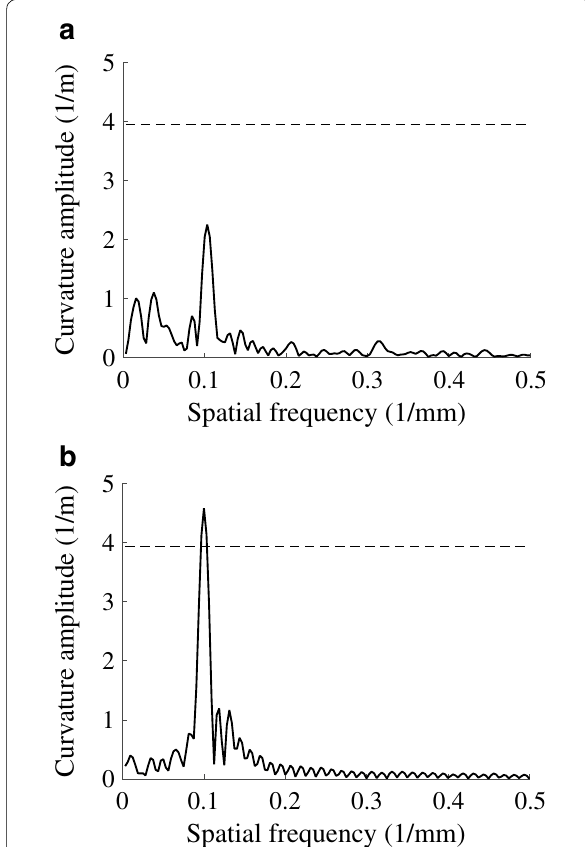
Fig. 7 Fourier analysis result of sensor signal. Each graph shows the result of a conventional sensor, and b our proposed sensor. The dotted line represents the curvature amplitude of the traced surface